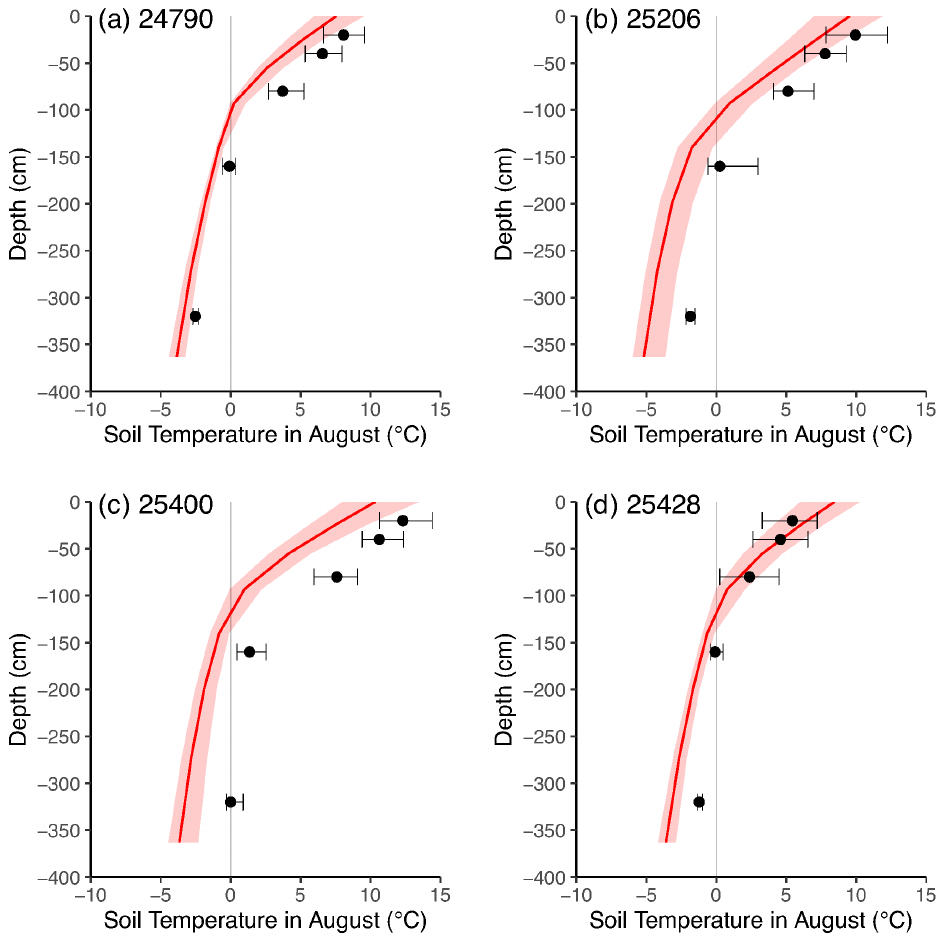
Figure 8. Vertical profiles of soil temperature climatology in August at four meteorological stations in the Kolyma River basin. Red lines and shaded area denote CHANGE simulation and 95% CIs, respectively. Black dots and error bars denote observed soil temperature and 95% CIs at meteorological stations, respectively. Site no: ( a ) 24,790, ( b ) 25,206, ( c ) 25,400, and ( d )